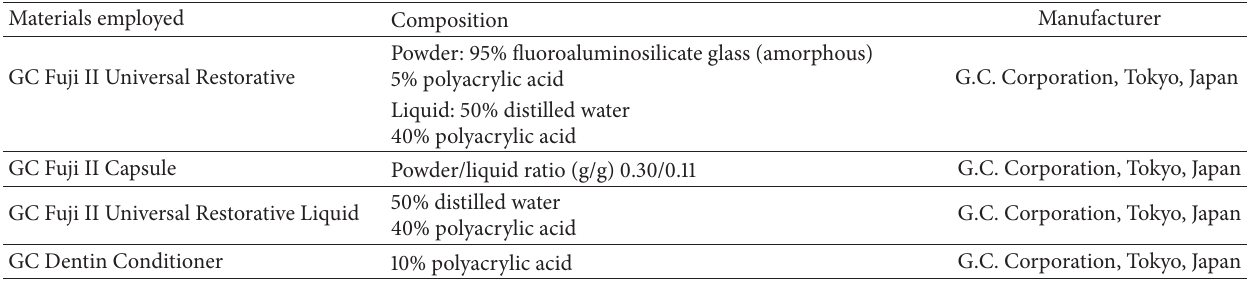
Table 1: Materials, composition, and manufacture.